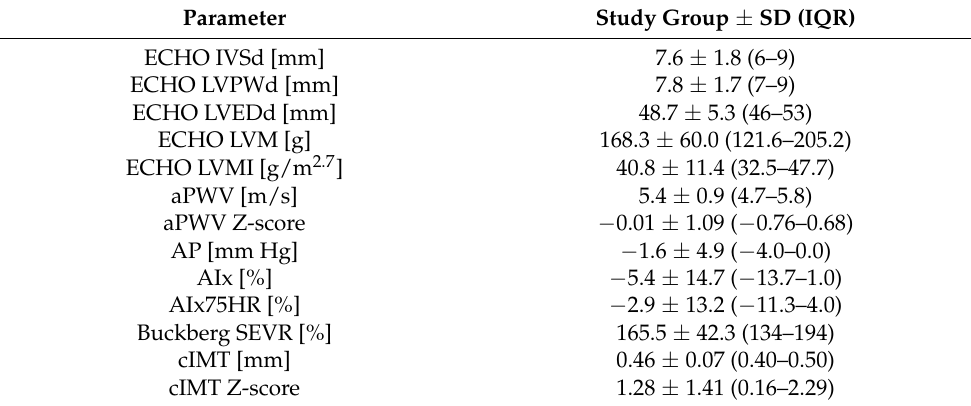
Table 4. Hypertension-mediated organ damage in the studied